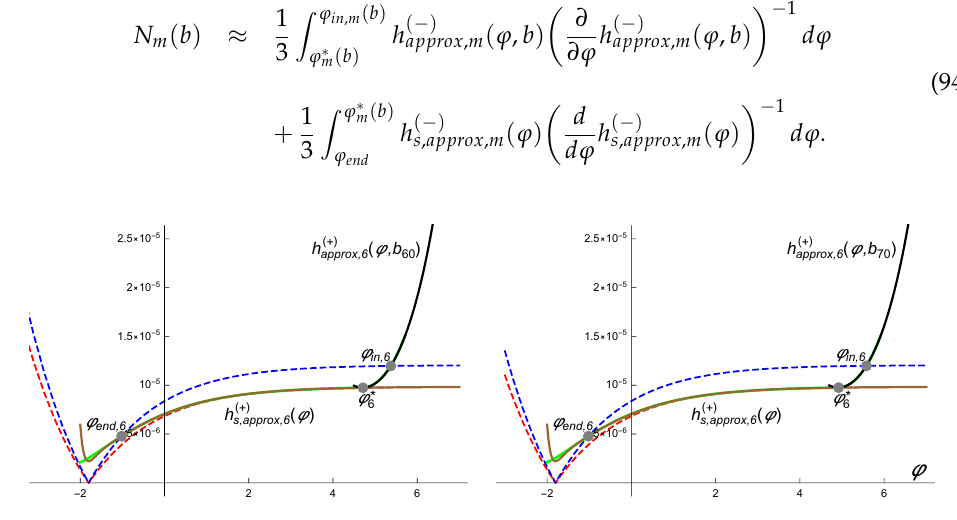
Figure 7. The green lines show the numerical solution h (+) ( ϕ ) of (26) with initial conditions ϕ 0 = (+) ( ϕ ) (left) and ϕ = 12, h = h (+) ( ϕ ) (right) for the model with 12, h 0 = h 0 , b 60 0 0 0 , b 70 approx ,6 approx ,6 √ √ 3 2 potential (11) and λ = , µ = , c 1 = 2 × 10 − 10 , c 2 = 2.5 × 10 − 10 . The black lines show the KD 3 4 (+) ( ϕ , b ) (left) and h (+) ( ϕ , b ) (right) and the brown lines represent the SR approximation h 60 70 approx ,6 approx ,6 (+) ( ϕ ) . The regions between blue and red dotted lines are the inflation regions. approximation h s , approx ,6 ( b ) and ϕ The gray dots correspond (from right to left) to ϕ in ,6 ( b 60 ) , ϕ ∗ 60 end ,6 (left) and ϕ in ,6 6 ( b ) and ϕ ϕ ∗ 70 end ,6 (right). 6